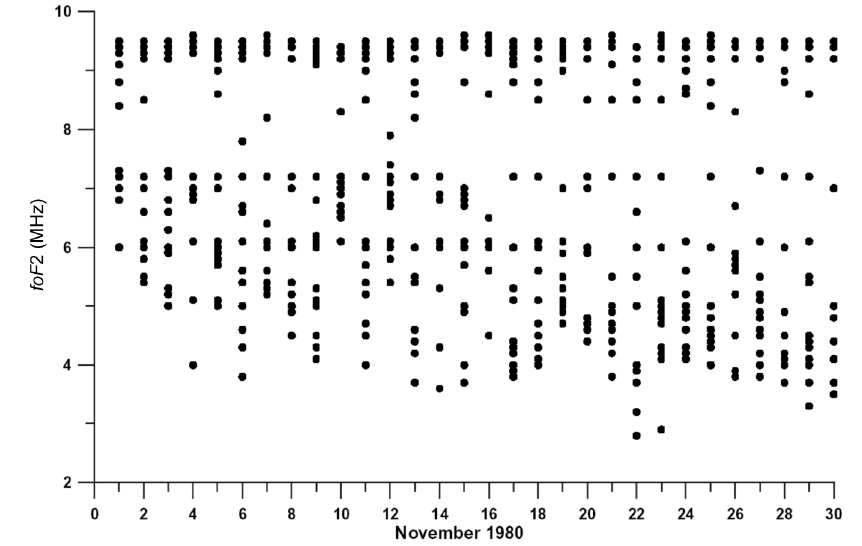
Fig. 9. Scattered plot for the critical frequency foF 2 for November 1980 (Athens ionospheric station).